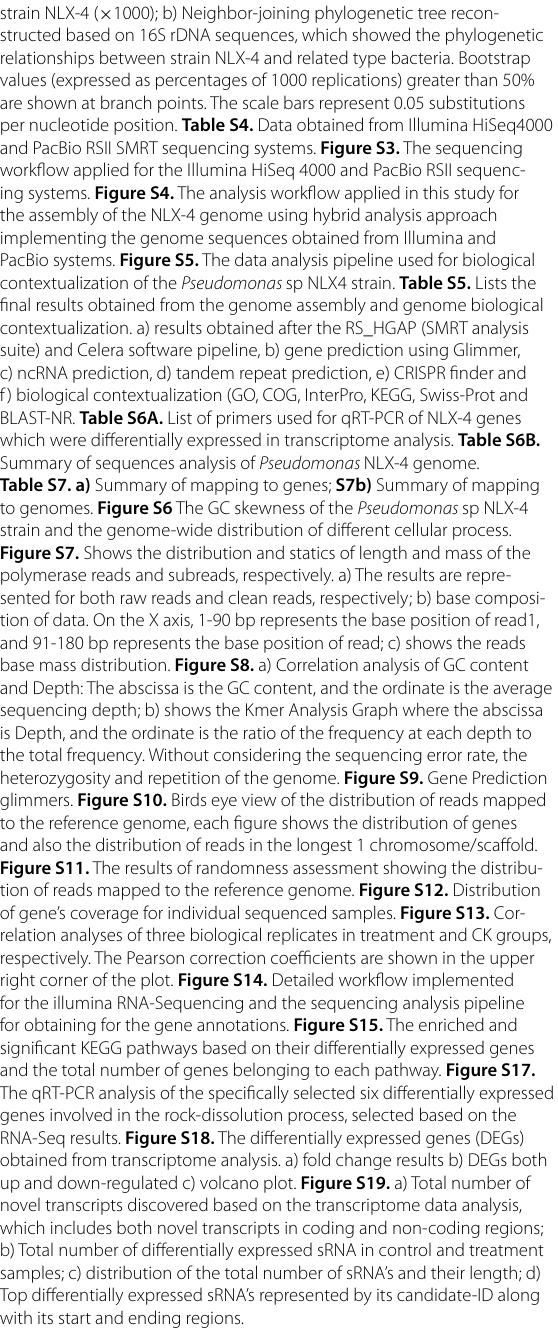
ing systems. Figure S4. The analysis workflow applied in this study for the assembly of the NLX-4 genome using hybrid analysis approach implementing the genome sequences obtained from Illumina and PacBio systems. Figure S5. The data analysis pipeline used for biological contextualization of the Pseudomonas sp NLX4 strain. Table S5. Lists the final results obtained from the genome assembly and genome biological contextualization. a) results obtained after the RS_HGAP (SMRT analysis suite) and Celera software pipeline, b) gene prediction using Glimmer,